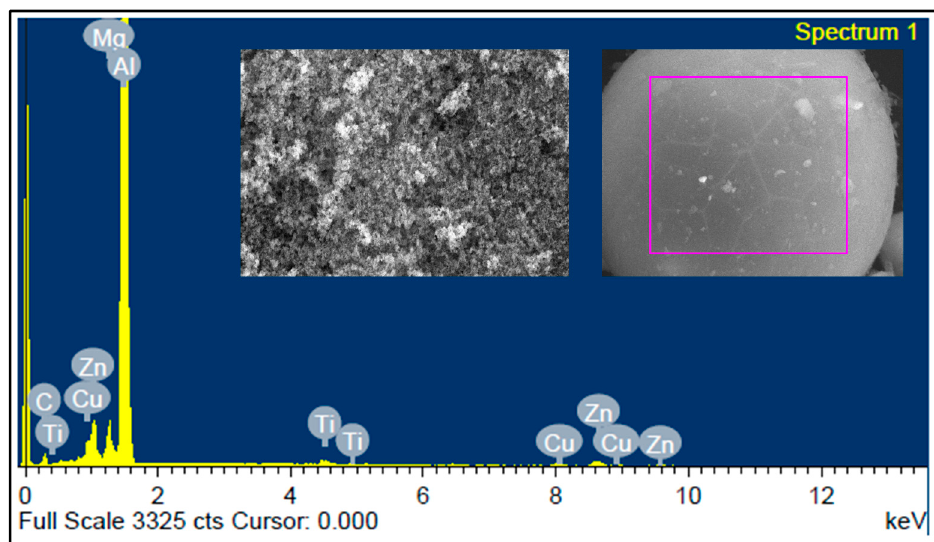
Figure 7. Analysis of Al 7075-4 wt.% TiC composite powder.